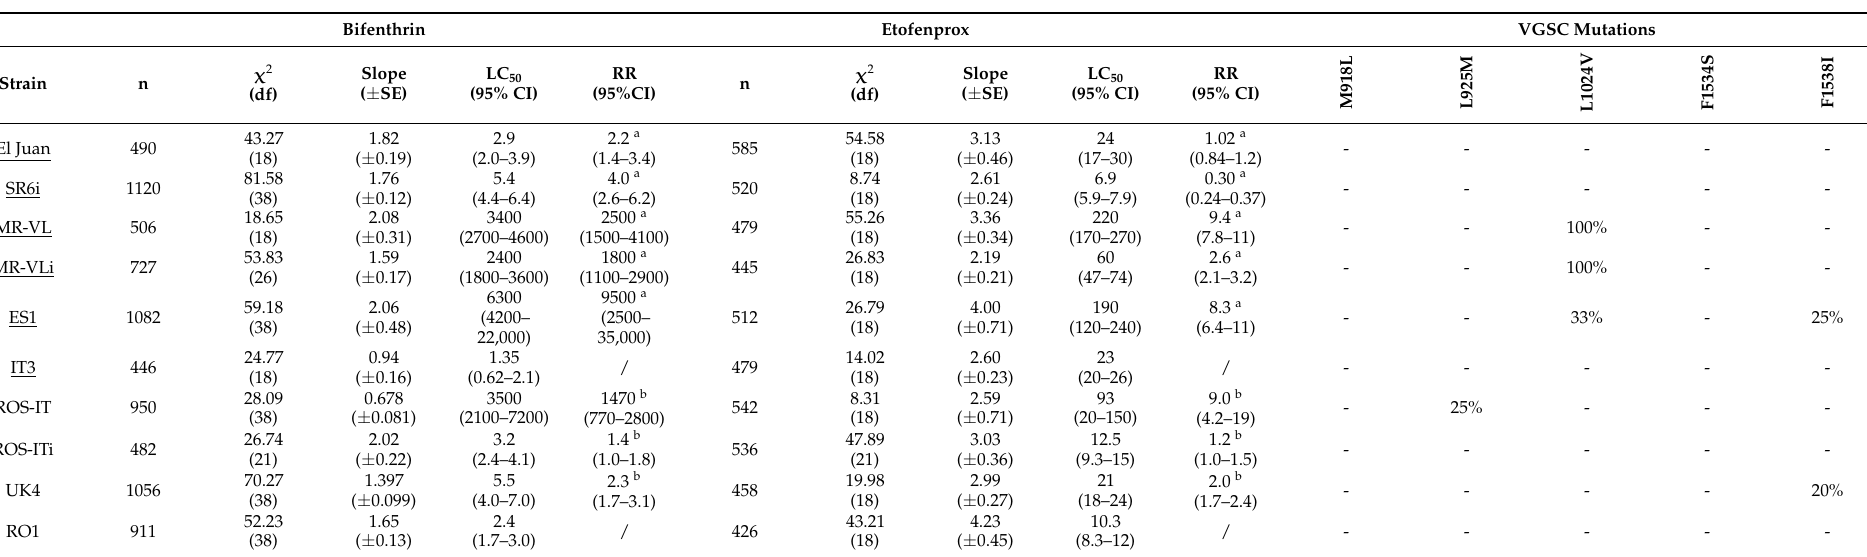
Table 1. LC 50 values for the pyrethroids bifenthrin and etofenprox, tested on several T. urticae strains, with resistance ratios (RR) calculated relative to IT3 and RO1 in the red and green strains, respectively, and the percentage of reads that align with the voltage-gated sodium channel (VGSC, tetur35g00970 ) and harbor resistance mutations. ( n = number of mites, LC 50 = lethal concentration for 50% of the subjects, df = degrees of freedom, SE = standard error, CI = confidence interval, RR = resistance ratio, df = degrees of